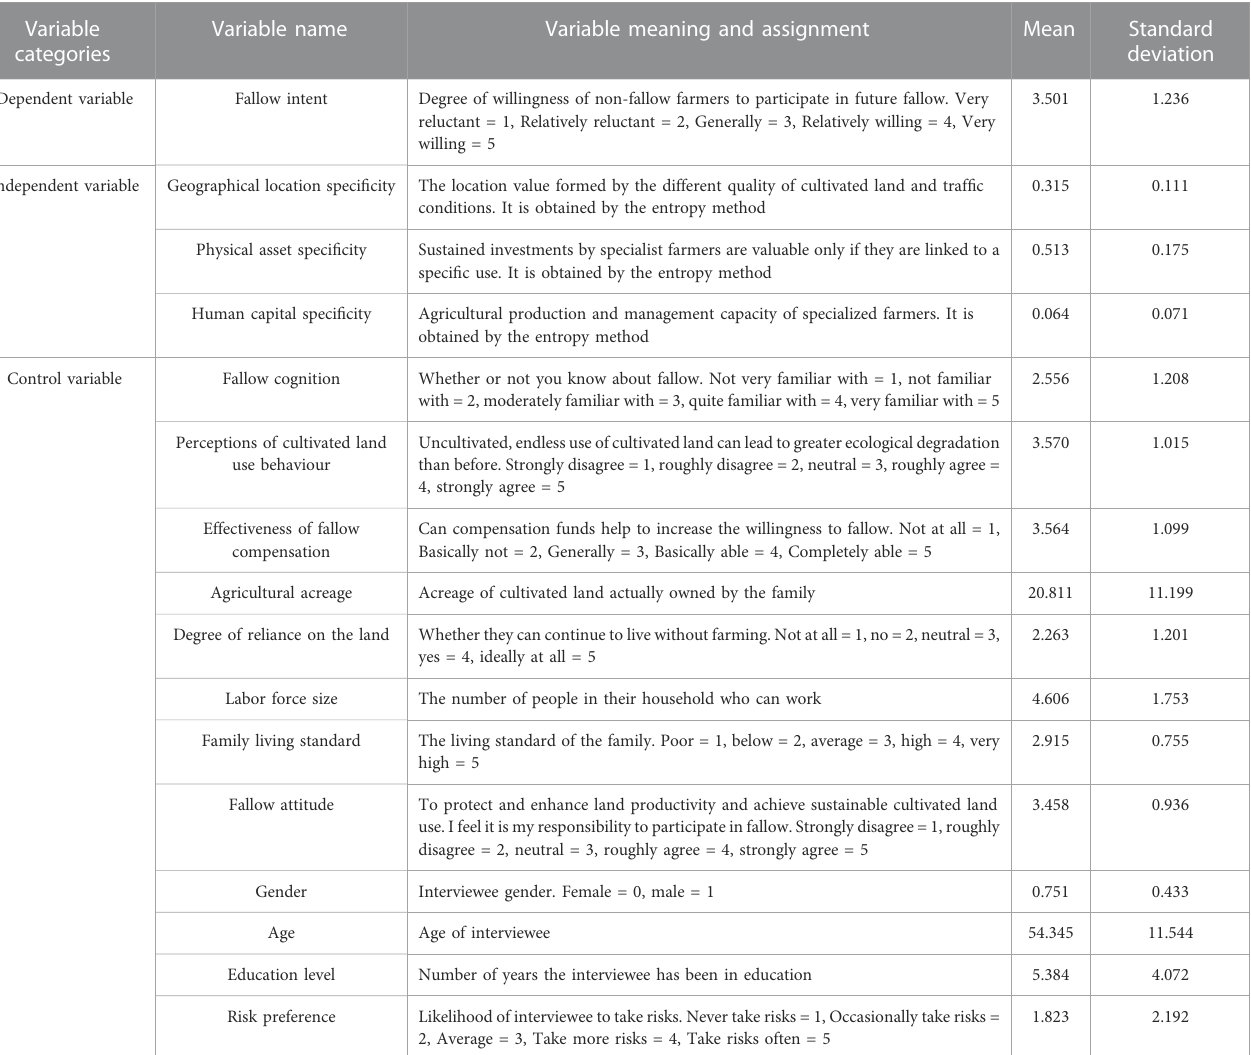
TABLE 2 Meaning of non-fallow farmers variables and their descriptive